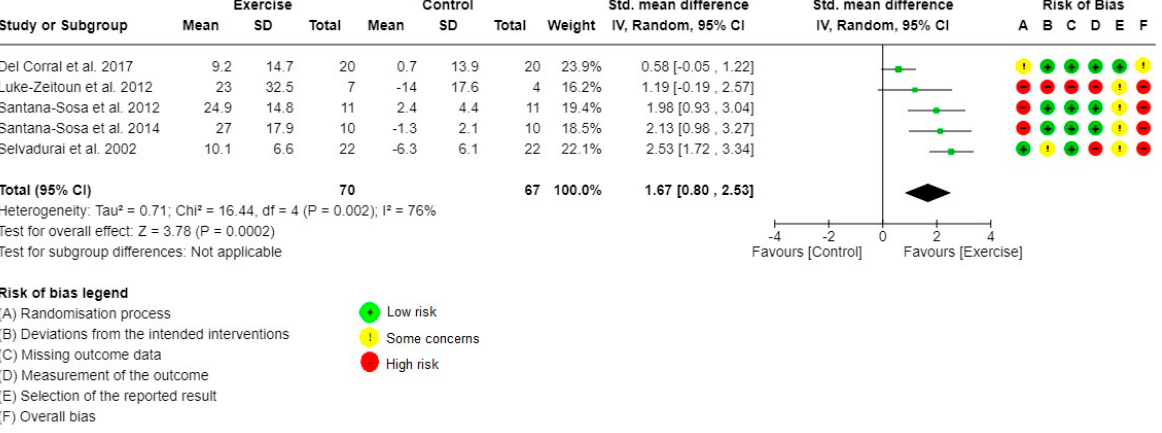
Figure 2. Forest plot for comparisons and risk of bias: Exercise versus Control, Outcome 1: Lower limb muscle strength.